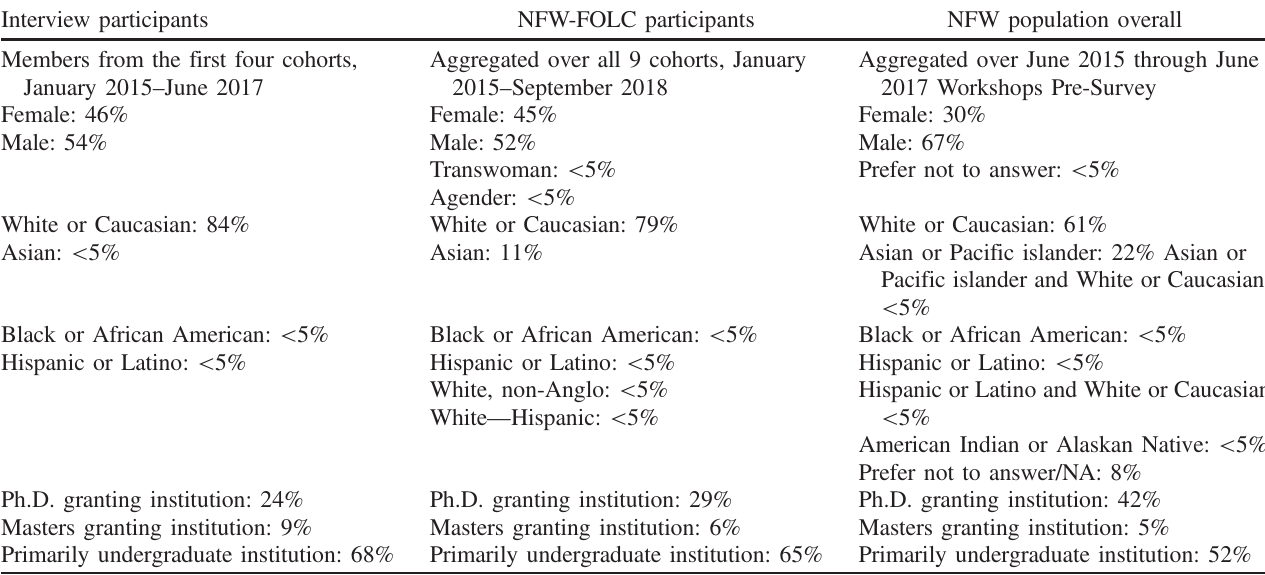
TABLE II. Demographic characteristics for interviewees, NFW-FOLC participants overall, and NFWattendees. Demographic data are reported based on collection categories which were not identical across groups. Note, the NFW population institution-type data is aggregated over the June 2016 through June 2017 workshops.